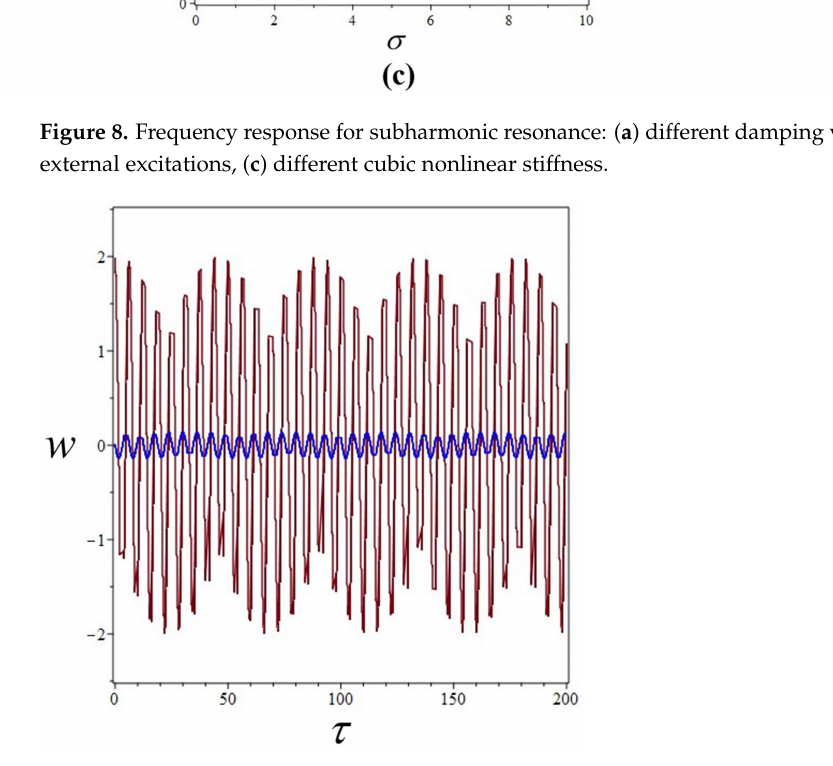
Figure 9. Dynamic response diagram of third harmonic resonance